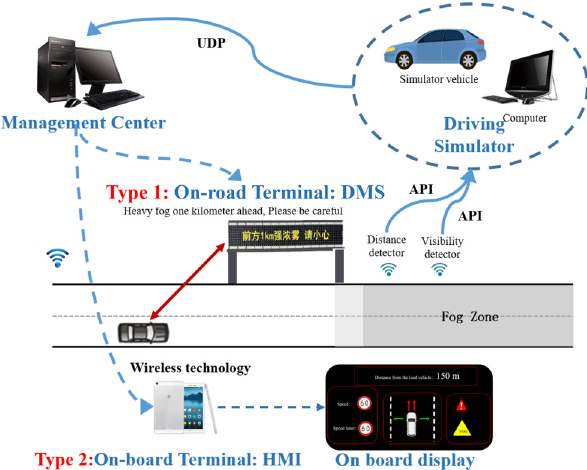
Figure 2 Connected vehicle testing platform